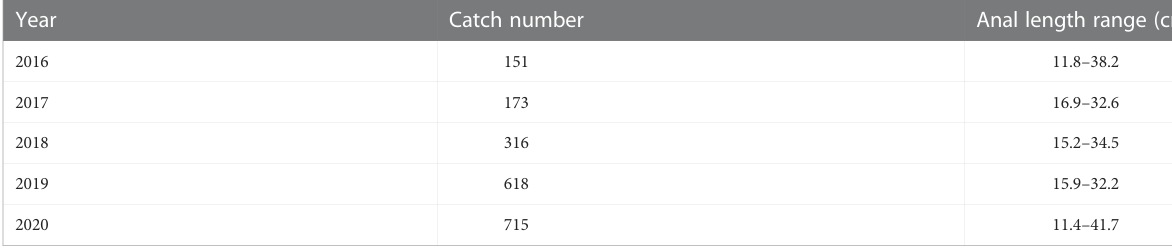
TABLE 1 Summary of year, catch number and anal length range of individuals measured of T. lepturus in the East China